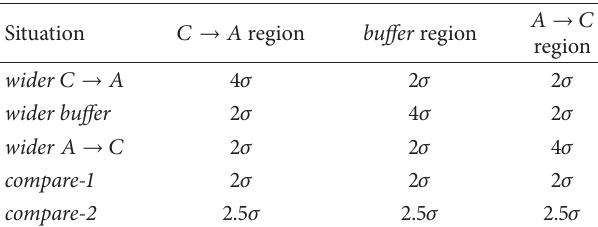
Table 6: Configuration situations of different widths of the func- tional